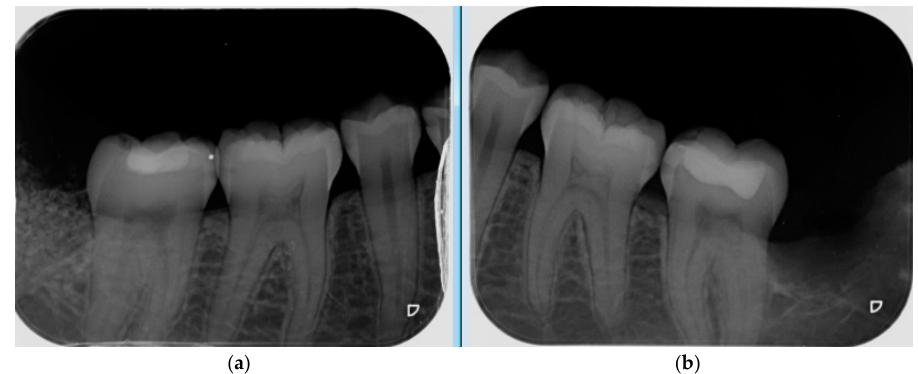
Figure 5. Intra-operative radiographs taken after autogenous dentin graft placement on study side ( a ) and Spontaneous healing with blood coagulate on control side ( b ).